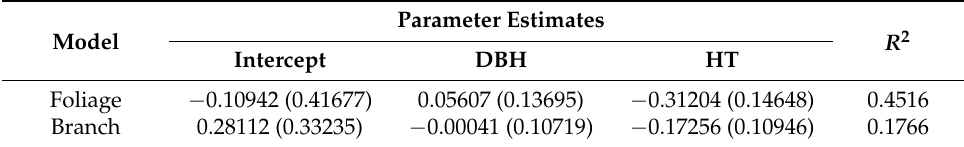
Table 7. Parameter estimates for the component biomass models for small DBH trees using multinomial logistic regression model. Component stem was used as the reference group.